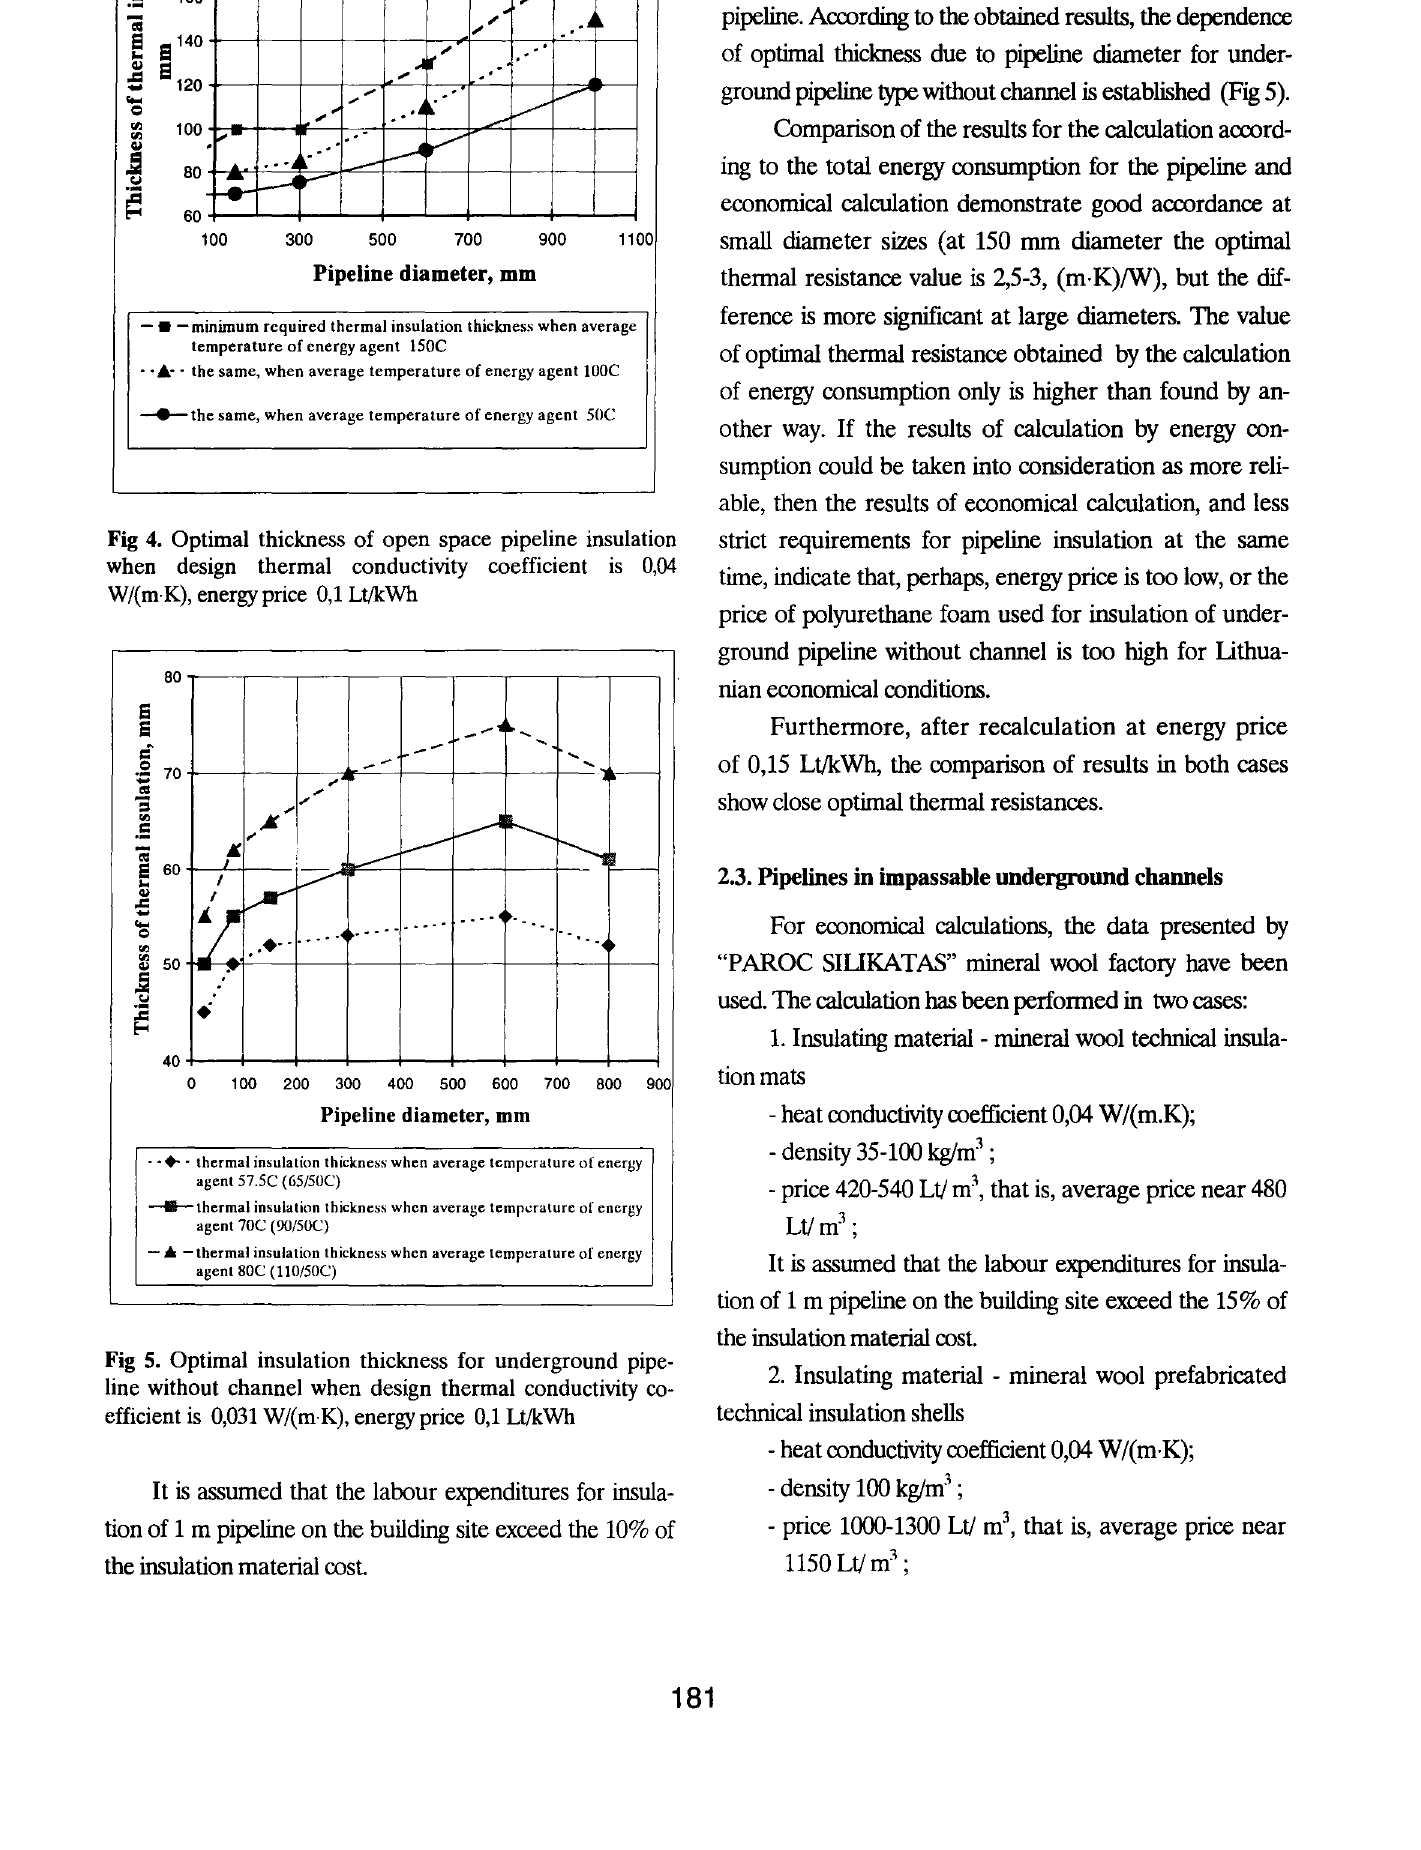
· ·A· · the same, when average temperature of energy agent lOOC ---the same, when average temperature of energy agent SOC